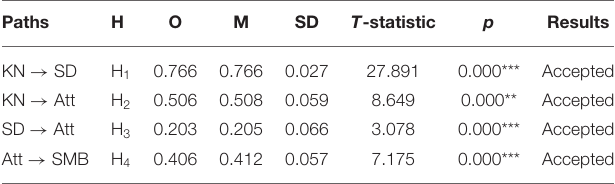
TABLE 7 | Hypothesis testing shows direct effects of the study